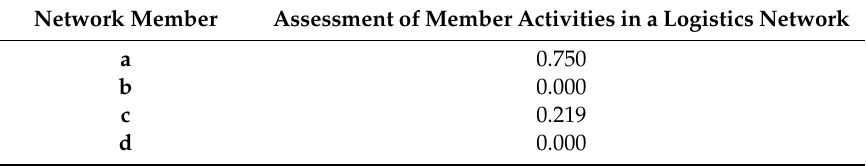
Table 4. A practical example of fuzzy subsets